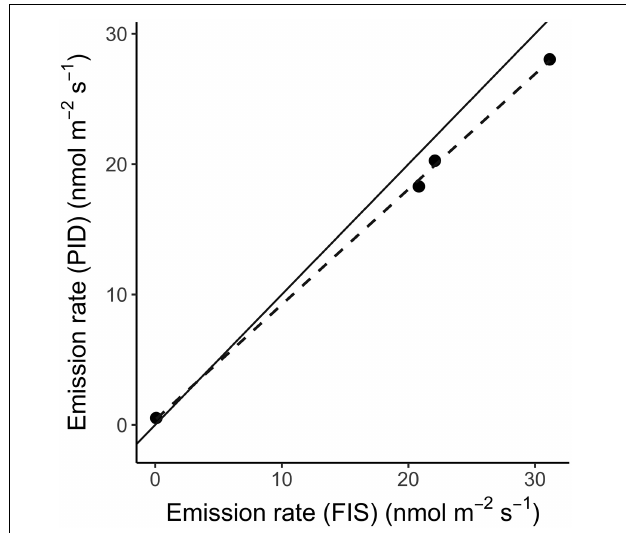
FIGURE 7 | Isoprene emission rates calculated from photoionization detector (PID) and Fast Isoprene Sensor (FIS) readings, averaged over the final two minutes of leaf illumination from four leaf samples (including those depicted in Figure 6 and an additional sample from Malpighia glabra , Supplementary Figure 4 ). The solid line is 1:1. The dashed line shows a linear regression through the data points ( r 2 = 0.999, slope =